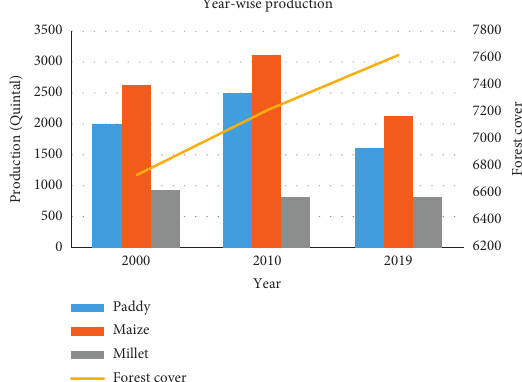
Figure 4: Productivity with an increase in forest